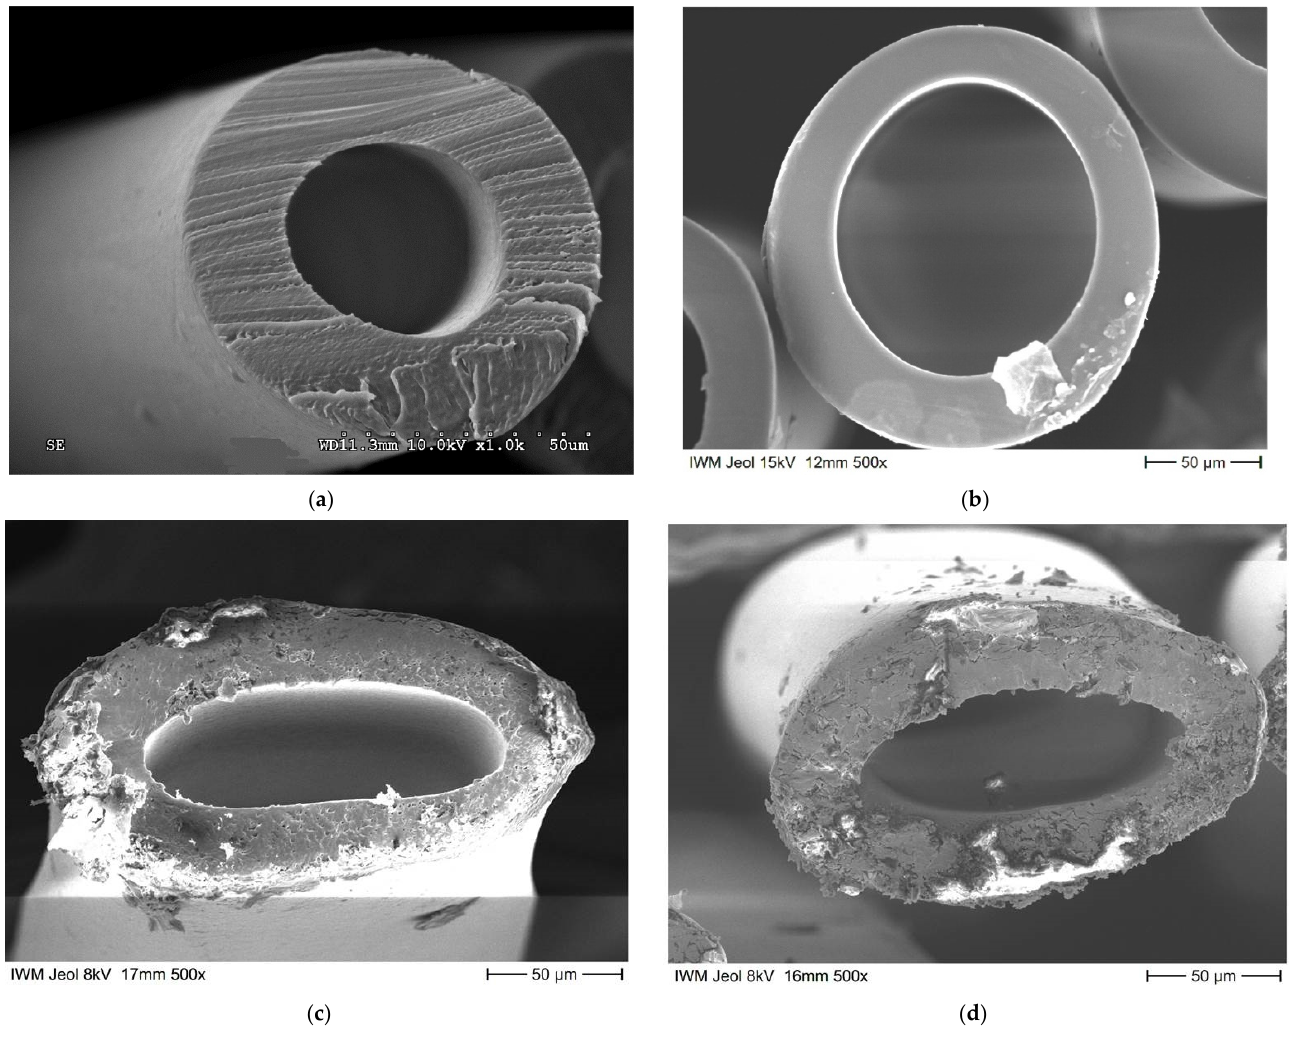
Figure 7. Cross section of HFs based on PMP: ( a ) Graviton HF; ( b ) HF_0 (undrawn); ( c ) HF_100_C (continuously drawn by 100% between unheated (20 °C) godets); ( d ) HF_100_80 (continuously drawn by 100% at 80 °C godet temperature). Table 2. Basic geometric dimensions of hollow fibers